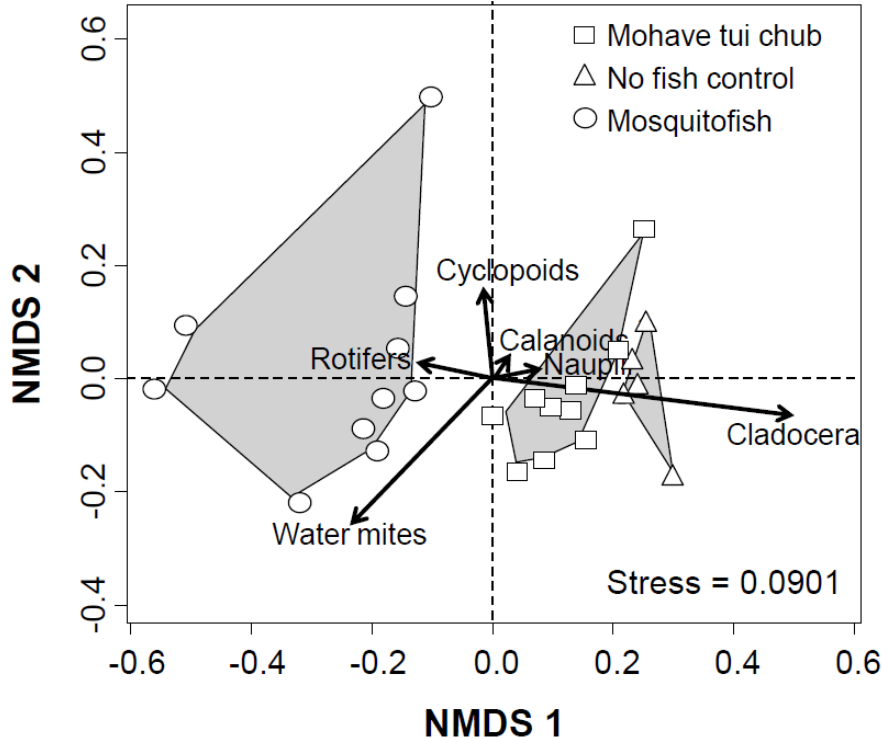
Figure 2. Nonmetric multidimensional scaling (NMDS) ordination plot of experimental units (= mesocosms) for all six-taxa of zooplankton (stress = 0.0901). Fish impacts are shown by having separate clusters for treatments with and without fish. Different symbols show three treatments; squares = mosquitofish, circles = Mohave tui chub, and triangles = fishless controls. Symbols represent individual mesocosms and the relative distance between two symbols represent the similarity (or dissimilarity) of zooplankton composition in the relevant mesocosms. Angles and lengths of the vectors represent the direction and the strength of responses of invertebrate taxa to ordination scores,